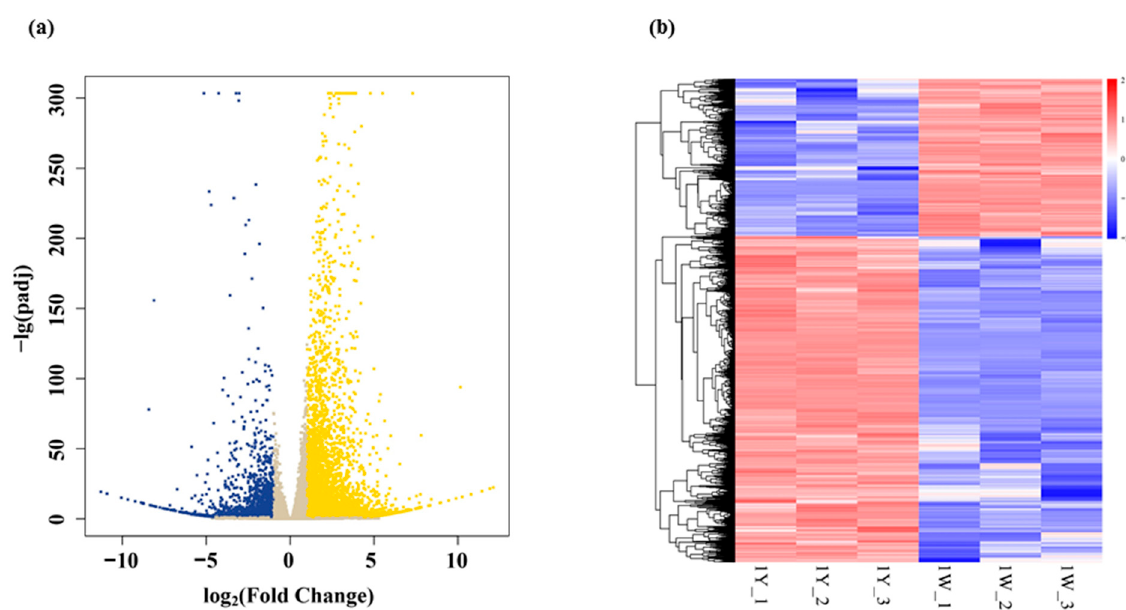
Figure 2. Classification analysis of differentially expressed genes. ( a ) Volcano plots of DEGs between 1Y and 1W. The yellow color indicates the upregulated DEGs, the blue were downregulated genes, and the grey color in the middle indicates the non-significantly genes. ( b ) Clustering analysis of DEGs in the wheat NILs. The x-axis represents different samples. 1Y_1, 1Y_2, 1Y_3 refer to the three replicates of high-NUE 1Y; 1W_1, 1W_2, 1W_3 refer to the three replicates of low-NUE 1W. The y-axis represents the differential genes expressed. Different colors show the genes and the expression levels of the genes are displayed by a color gradient from low (blue) to high (red).